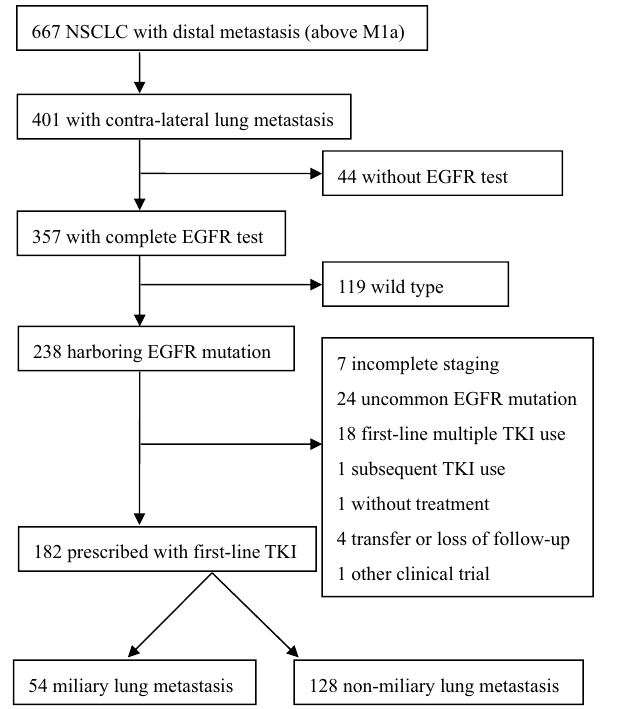
Figure 2. Flow chart of patients